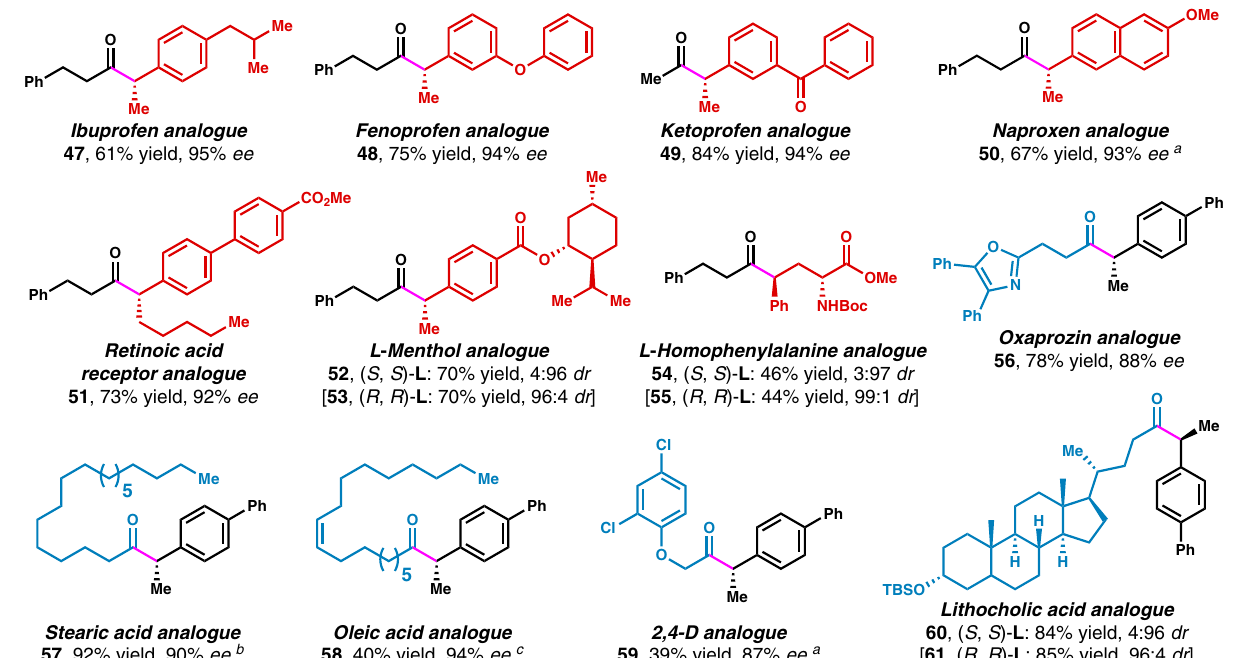
Fig. 3 Late-stage functionalization. All data represent the average of two experiments. Unless otherwise stated, reactions were conducted on a 0.5 mmol scale under standard conditions. a In place of the standard conditions, the reaction was conducted at 25 °C in dioxane. b In place of the standard conditions, the reaction was conducted at 25 °C. c In place of the standard conditions, 5.0 equiv of 4-ethylbiphenyl was used.